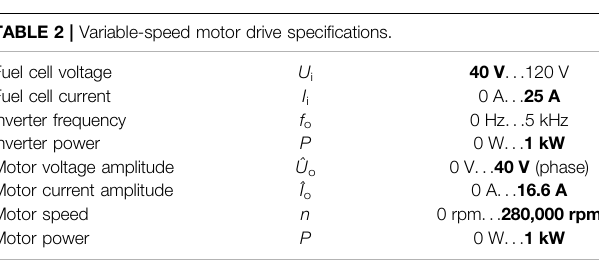
TABLE 2 | Variable-speed motor drive speci fi cations.